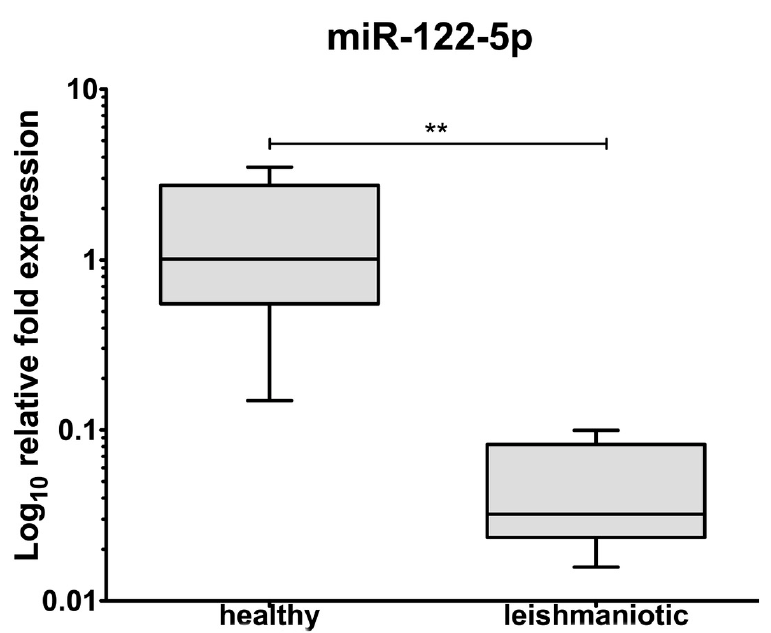
Figure 3. Expression of miR-122 gene expression in canine serum exosomes from healthy ( n = 10) and leishmaniotic ( n = 10) dogs. Boxes and whiskers graph. The boxes indicate the quartiles and the mean. **: p < 0.01.